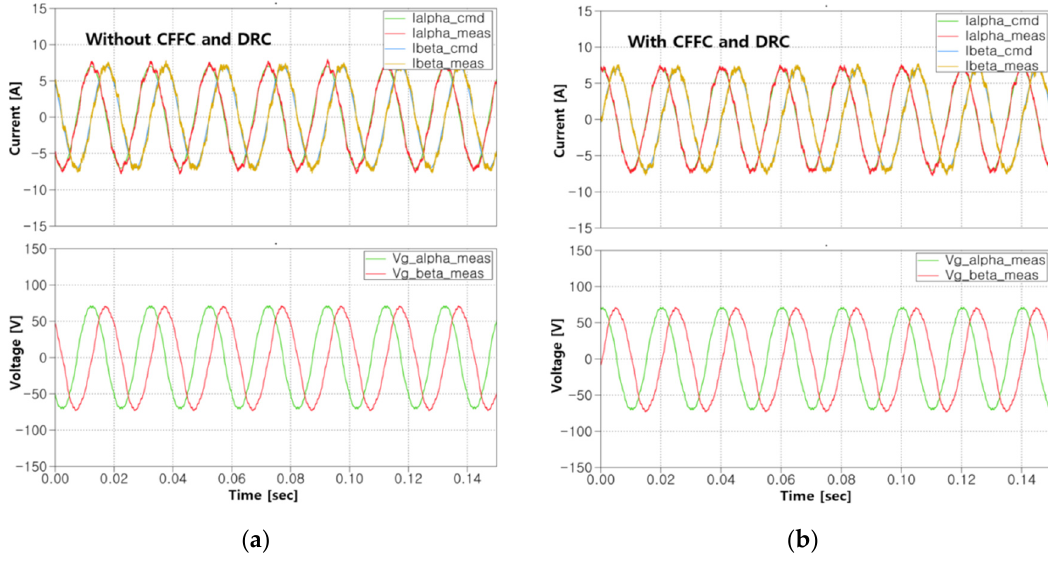
Figure 15. When 5th, 7th harmonics are injected to the grid, experimental results of the stationary reference frame grid currents and grid voltages ( a ) without CFFC and DRC and ( b ) with CFFC and DRC. Table 7. Experiment results of GCI system phase current THD when 5th, 7th harmonics injected grid condition.